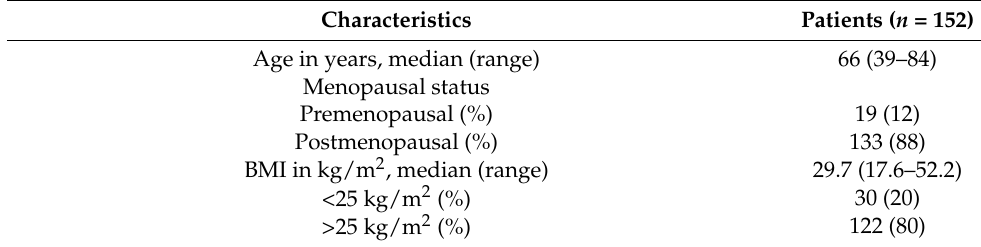
Figure 1. Identification and inclusion of patients in the SLIM study. * SLN = sentinel lymph node. Table 1. Clinical, surgical and pathological